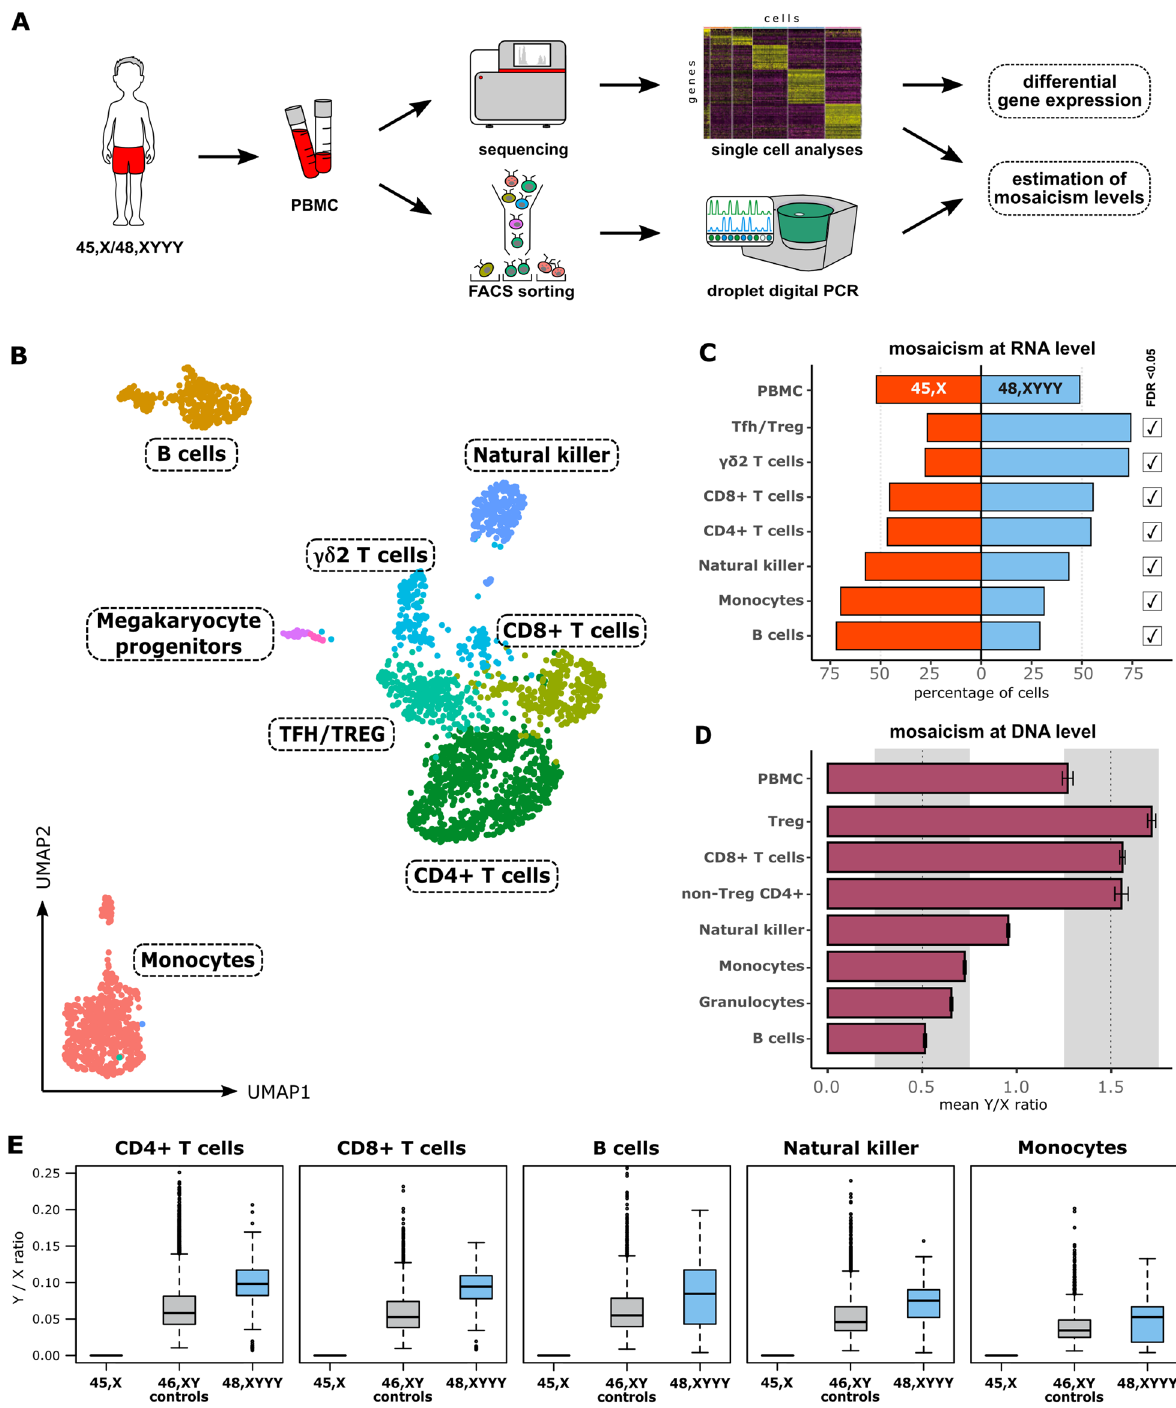
Figure 2. Summary of single-cell RNA sequencing analysis. Panel ( A ) shows a schematic overview of the experimental design. Panel ( B ) shows two-dimensional UMAP projection of the single-cell RNA sequencing (scRNA-seq) data. Eight main clusters of immune cells are colored according to their inferred cell type. Each colored dot corresponds to a single cell. Panel ( C ) shows distribution of the two mosaic populations 45, X (red) and 48, XYYY (blue) in the total sample of peripheral blood mononuclear cells (PBMC) and in the selected major subpopulations at single cell level. Expression of any single Y-linked gene was used to assign cells to the 48, XYYY fraction. The checkboxes on the right side of the plot indicate whether the differences of a given cell type between 45, X and 48, XYYY cells are significant (FDR < 0.05, p values compute with Monte Carlo permutation test) and are not an effect of random sampling (details in Table S12 in the Supplementary Information). Panel ( D ) shows mosaicism level assessment by digital droplet PCR (ddPCR) using the AMELX/AMELY assay. Individual’s fractions of the FACS-sorted cells stay in agreement with the immune cell fractions from scRNA-seq in terms of the ratios of Y and X-containing subpopulations. Panel ( E ) shows ratios of the Y-linked to X-linked expression in the 48, XYYY cell population as compared to the public PBMC data of healthy males. Labels on the X axis correspond to the IDs of donors used in the public datasets or their age (for GSE128879 ). In each of the graphs the 48, XYYY fraction of the studied individual’s PBMC displays a much higher Y/X ratio than the males used for comparison (details in Fig.